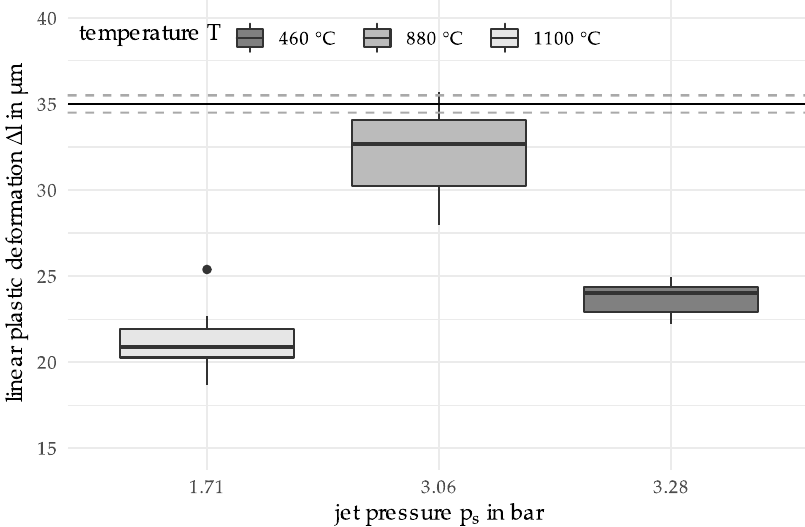
Figure 7. Boxplots for the new measurements; second boxplot corresponds to the suggested predictor values in iteration 1.